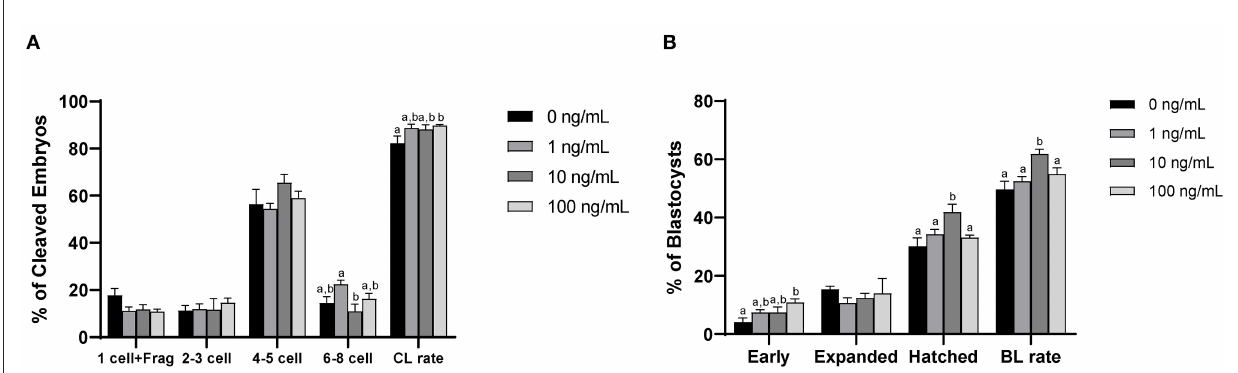
FIGURE7 Effect of CCL2 supplementation during IVM on the cleavage (CL) pattern (A) and blastocyst (BL) formation pattern (B) of PA embryos. Within each end point, bars with different letters (a, b) differ significantly ( p < 0.05) for different concentrations of CCL2. Fragmentation; Frag. The cleavage and blastocyst rates were evaluated on days 2 and 7 after PA, respectively. The experiment was replicated three